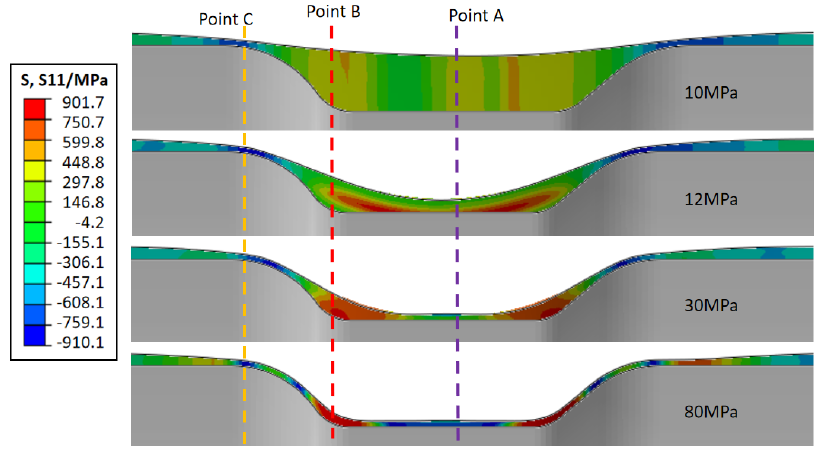
Figure 15. The axial stress variation during compressive deformation.